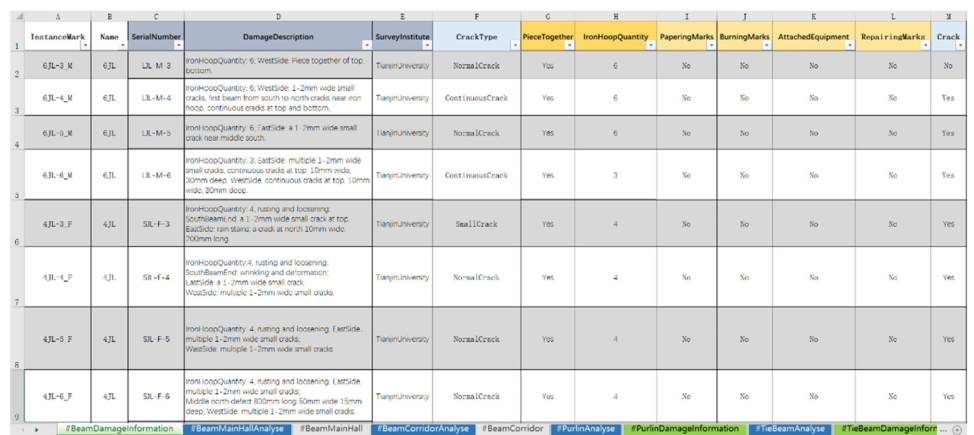
Figure 16. The condition information